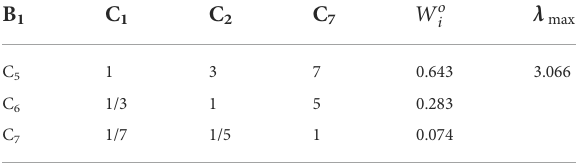
TABLE 3 Weights of fi rst-tier indicators.